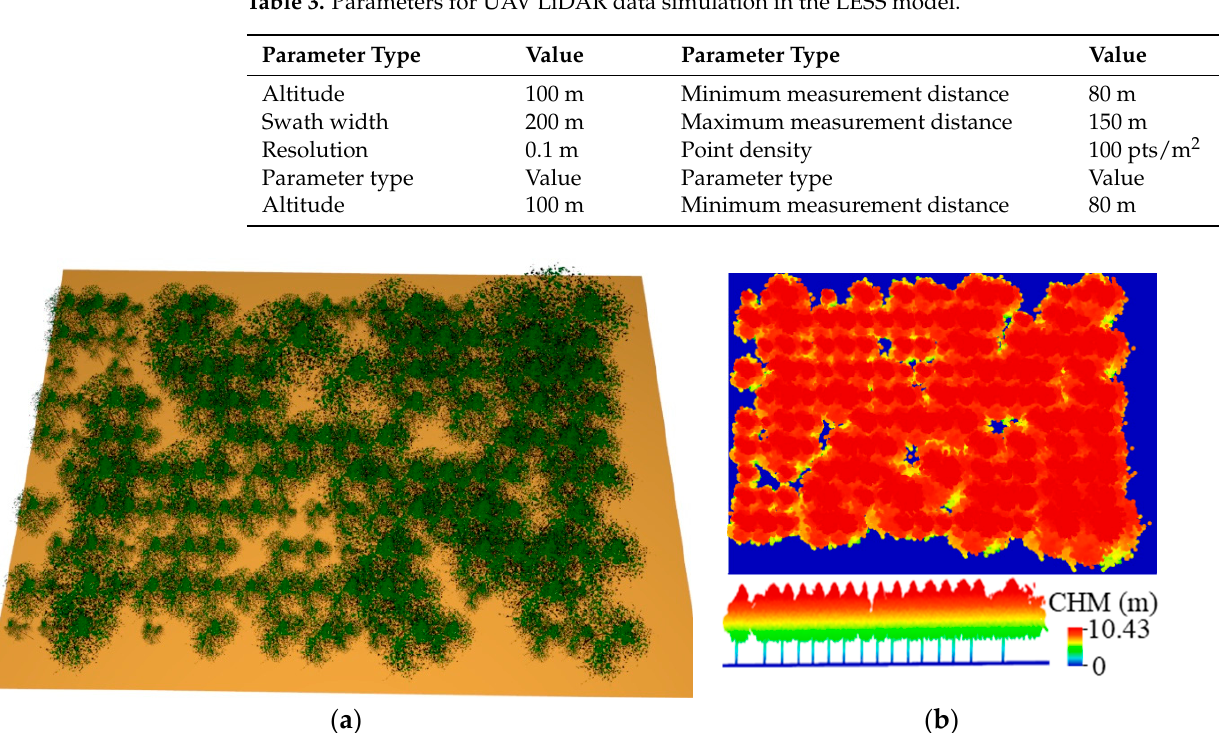
Figure 2. Simulated UAV LiDAR data. ( a ) Simulated scene and ( b ) simulated point data and pro-